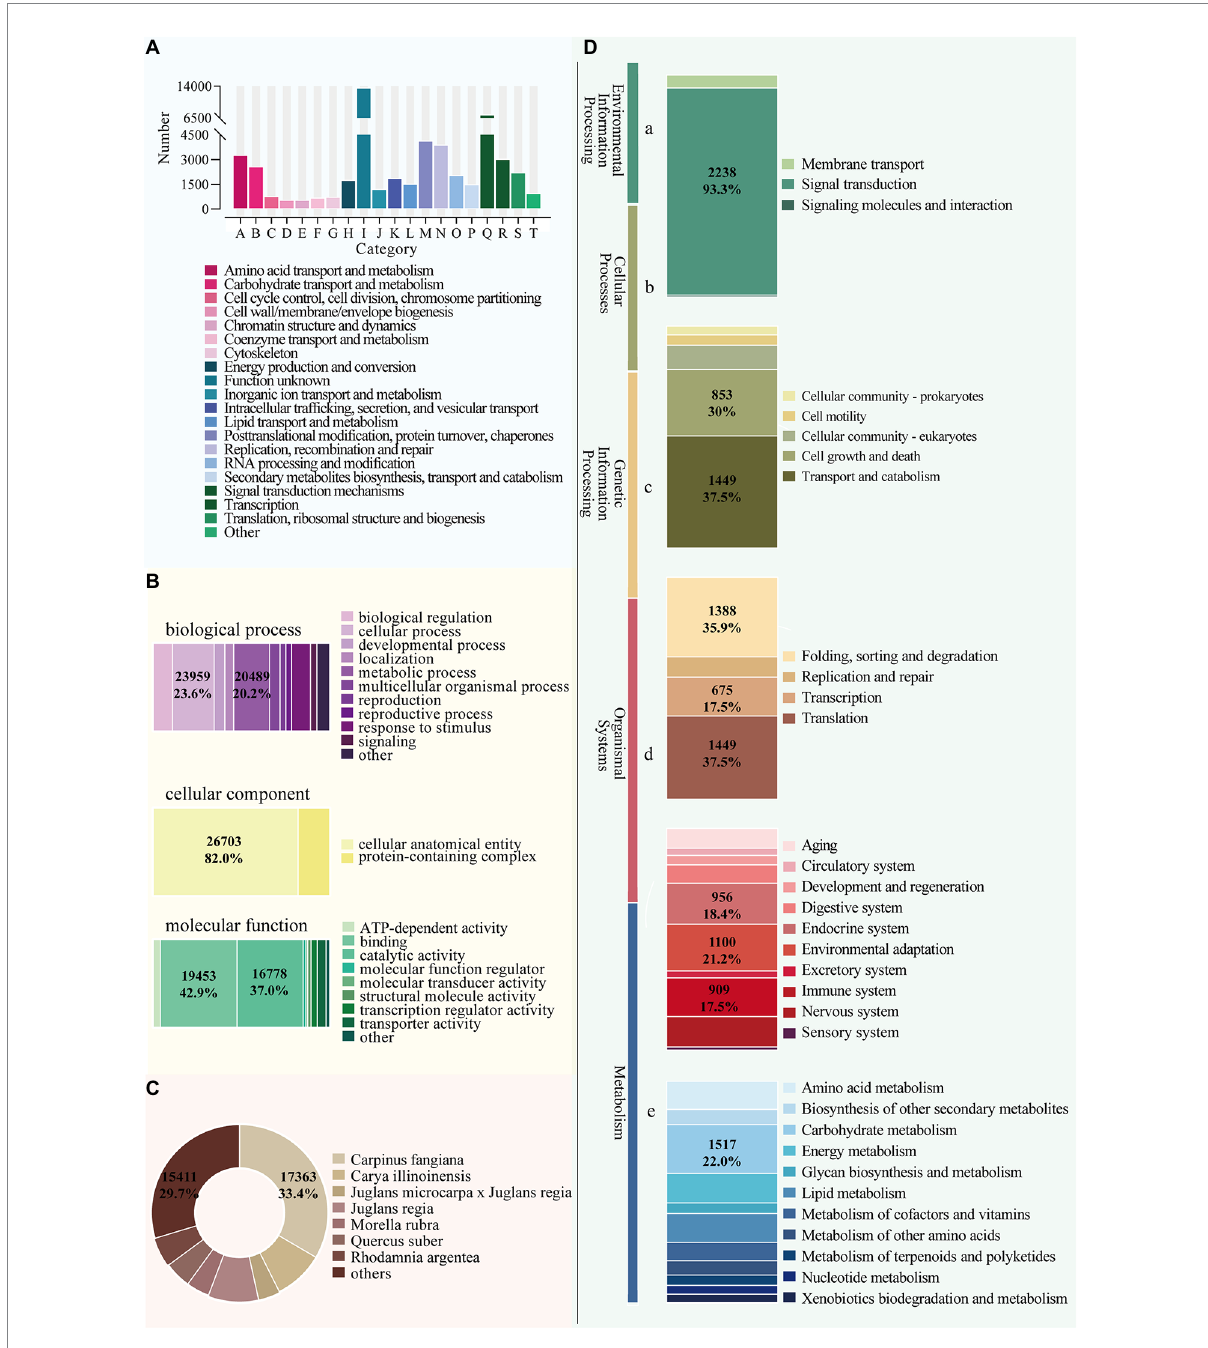
FIGURE 6 Functional annotation of B. luminifera unigenes generated by illumine sequencing. (A) Functional classification of unigenes by eggNOG analysis. (B) Functional classification of unigenes by GO analysis. (C) Functional annotation of unigenes by NR analysis. (D) A total of 21,184 unigenes were assigned to different KEGG terms. Different color blocks represent different terms, from top to down, “Environmental Information Processing” (a), “Cellular Processes” (b), “Genetic Information Processing” (c), “Organismal Systems” (d), and “Metabolism”